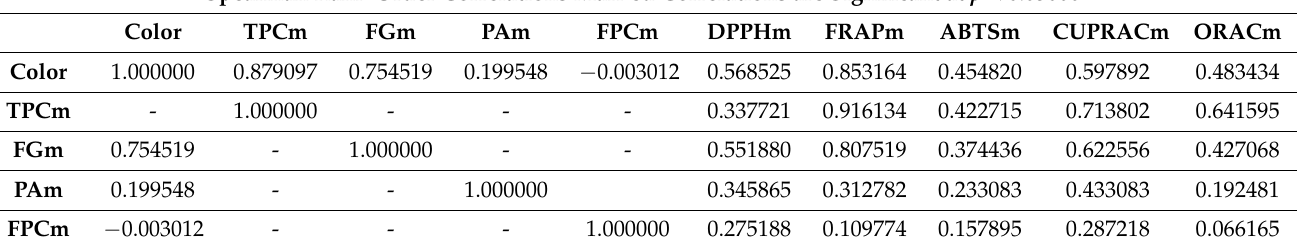
Table 3. Correlation analysis of methanol malt